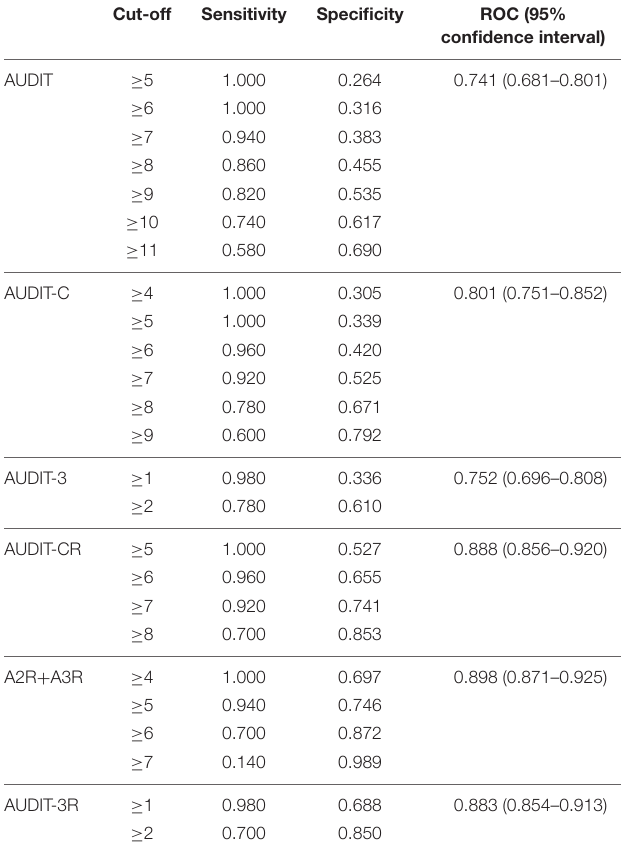
TABLE 4 | Performance of the three versions of the AUDIT in detecting binge drinking for the entire sample. Cut-off Sensitivity